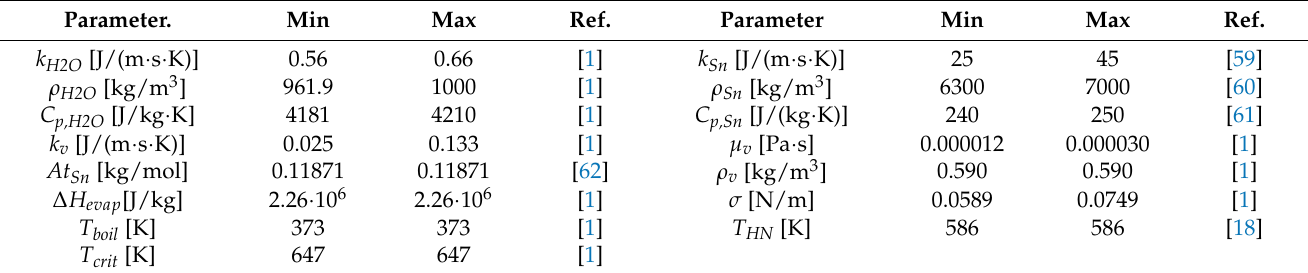
Figure 6. Role of material properties in formulas for relevant combinations of melt temperature ( T hot , X-axis) and coolant temperature ( T l , Y-axis): ( A ) T HN and T crit represent combinations that cause the interface temperature to equal the homogeneous nucleation temperature ( T HN ) and the critical temperature ( T crit ), respectively (Equation (8)); ( B ) minimum film boiling temperature: T hydro and T thermal represent the hydrodynamic (Equation (3)) and thermal model (Equation (4)), respectively. The annotations ‘min’ and ‘max’ relate to higher or lower transition temperature. Table 1. Material properties used to obtain Figure 6. Parameter.